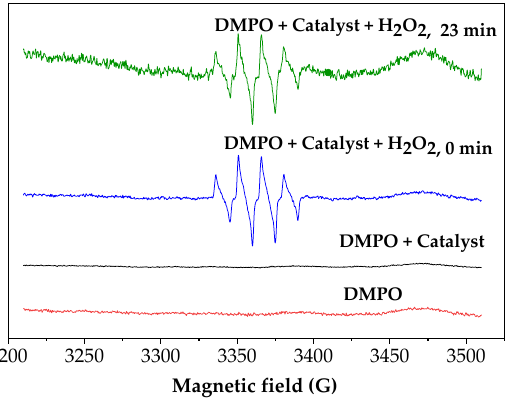
Figure 7. EPR spectra of DMPO, DMPO with catalyst, and DMPO adducts formed in CWPO reac- tion.